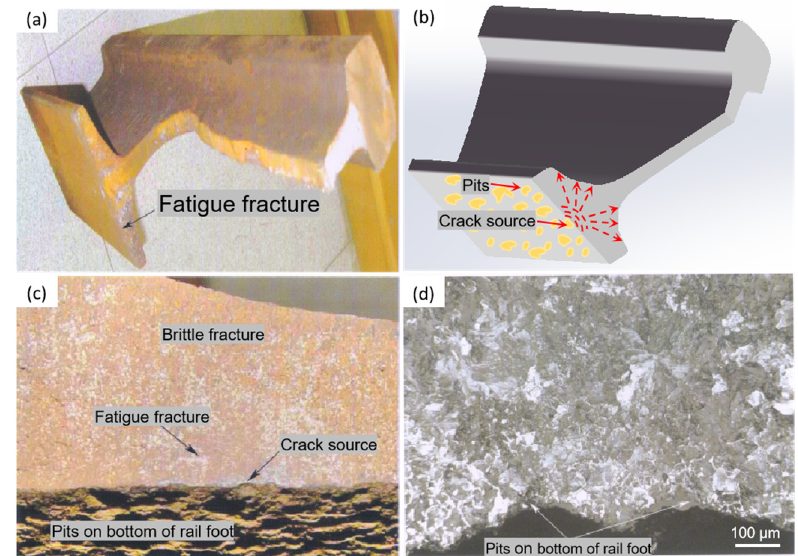
Figure 1. Fatigue fracture of the joint: ( a ) Fatigue fracture; ( b ) the schematic diagram of pits; ( c ) pits on bottom of rail foot; ( d ) metallographic structure around pits.